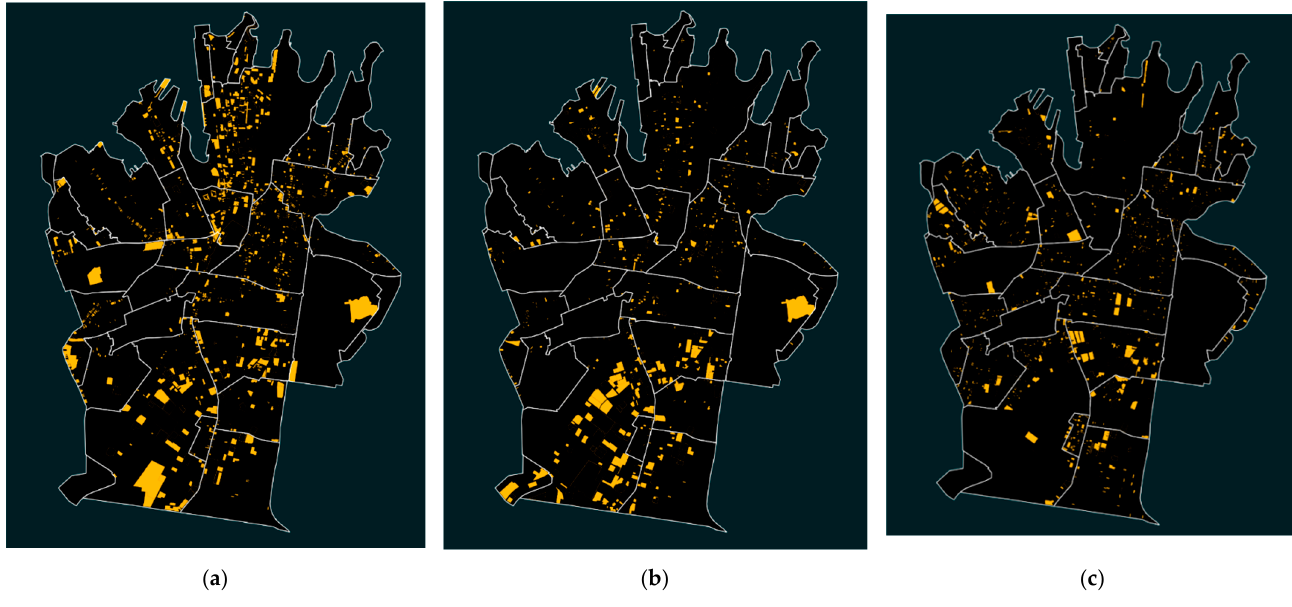
Figure 37. Mapping of selected DA locations (marked in yellow) across the study period (2004–2022): ( a ) DAs identified as for retail use ( b ) DAs identified as for commercial use ( c ) DAs identified as for residential use.